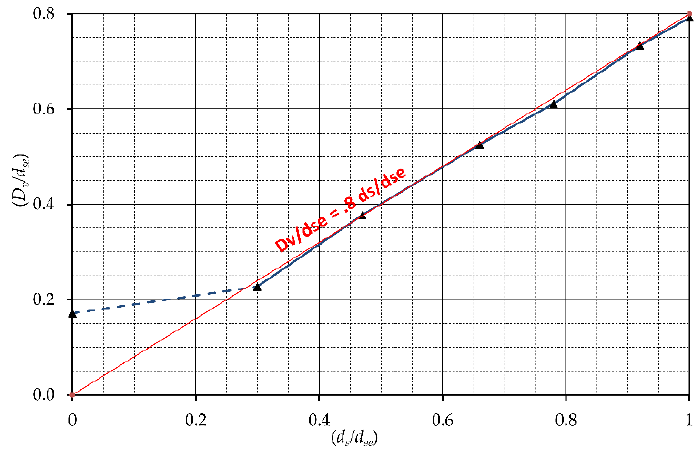
Figure 19. Development of the HV vortex mean size during the development of the scour hole.